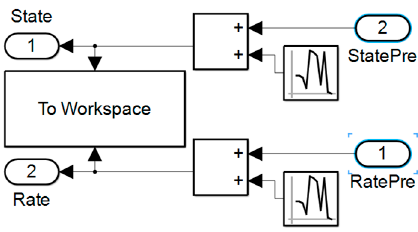
Figure A7. Spacecraft simulation topology.